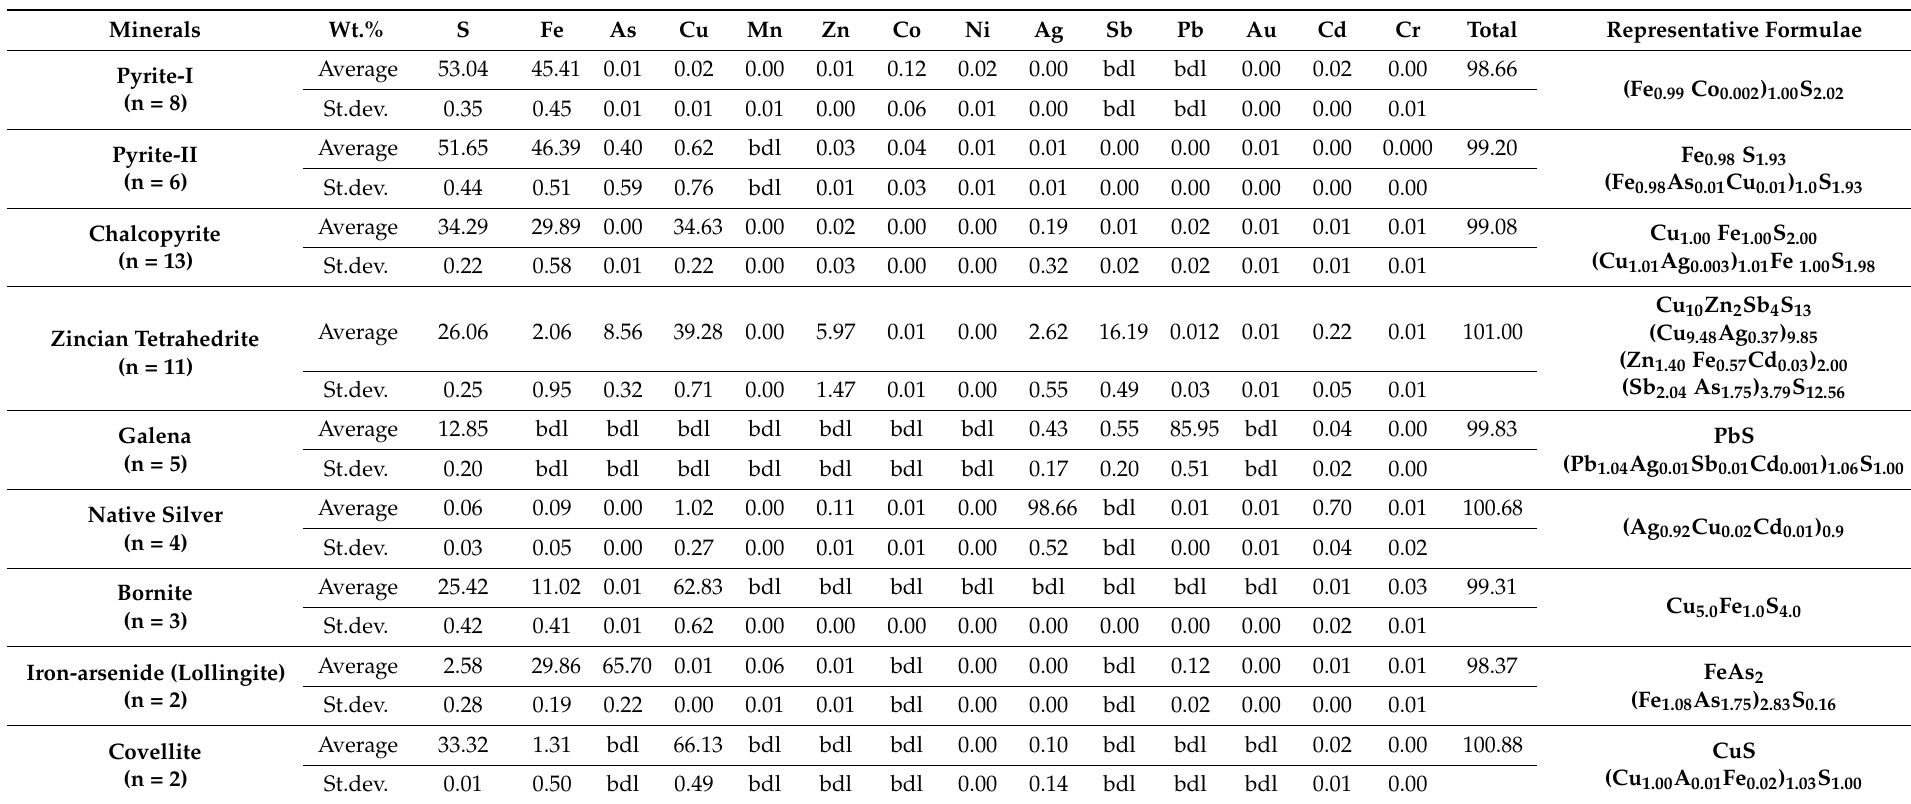
Table 1. Representative compositions of ore-forming minerals based on electron microprobe analyzer (EPMA). bdl, below detection limit.